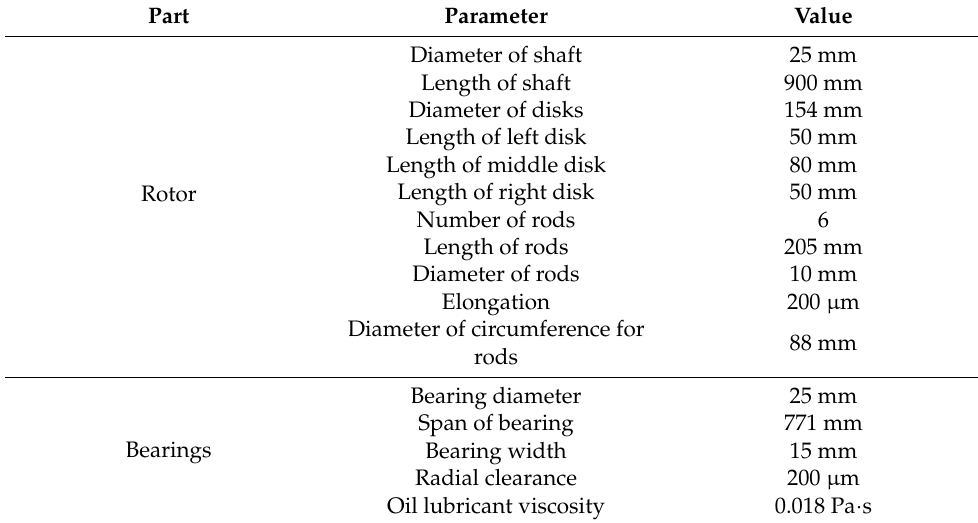
Table 2. Parameters of rod–disk rotor bearing system.